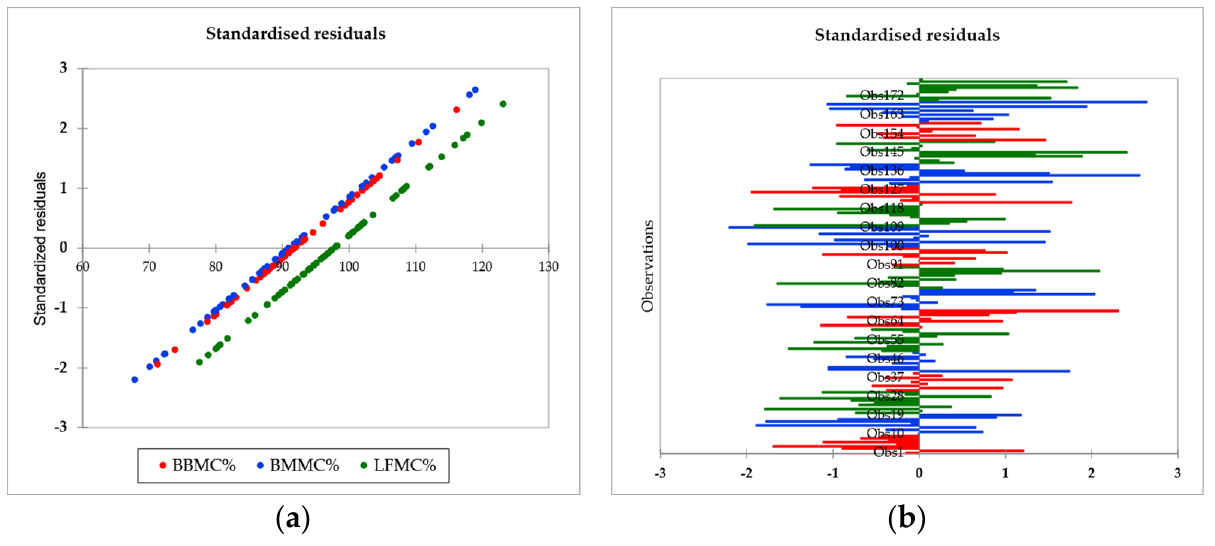
Figure 4. Standardised residual analyses among BBMC%, BMMC% and LFMC% for the total period ( a ) and standardised residual vs total observations ( b ).